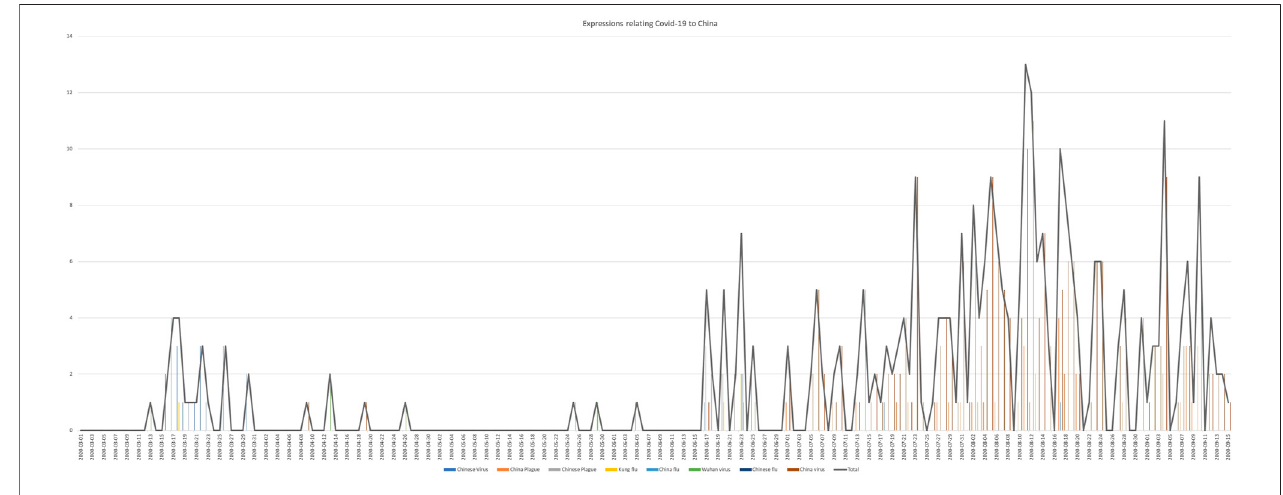
FIGURE 1 | Expressions relating COVID-19 to